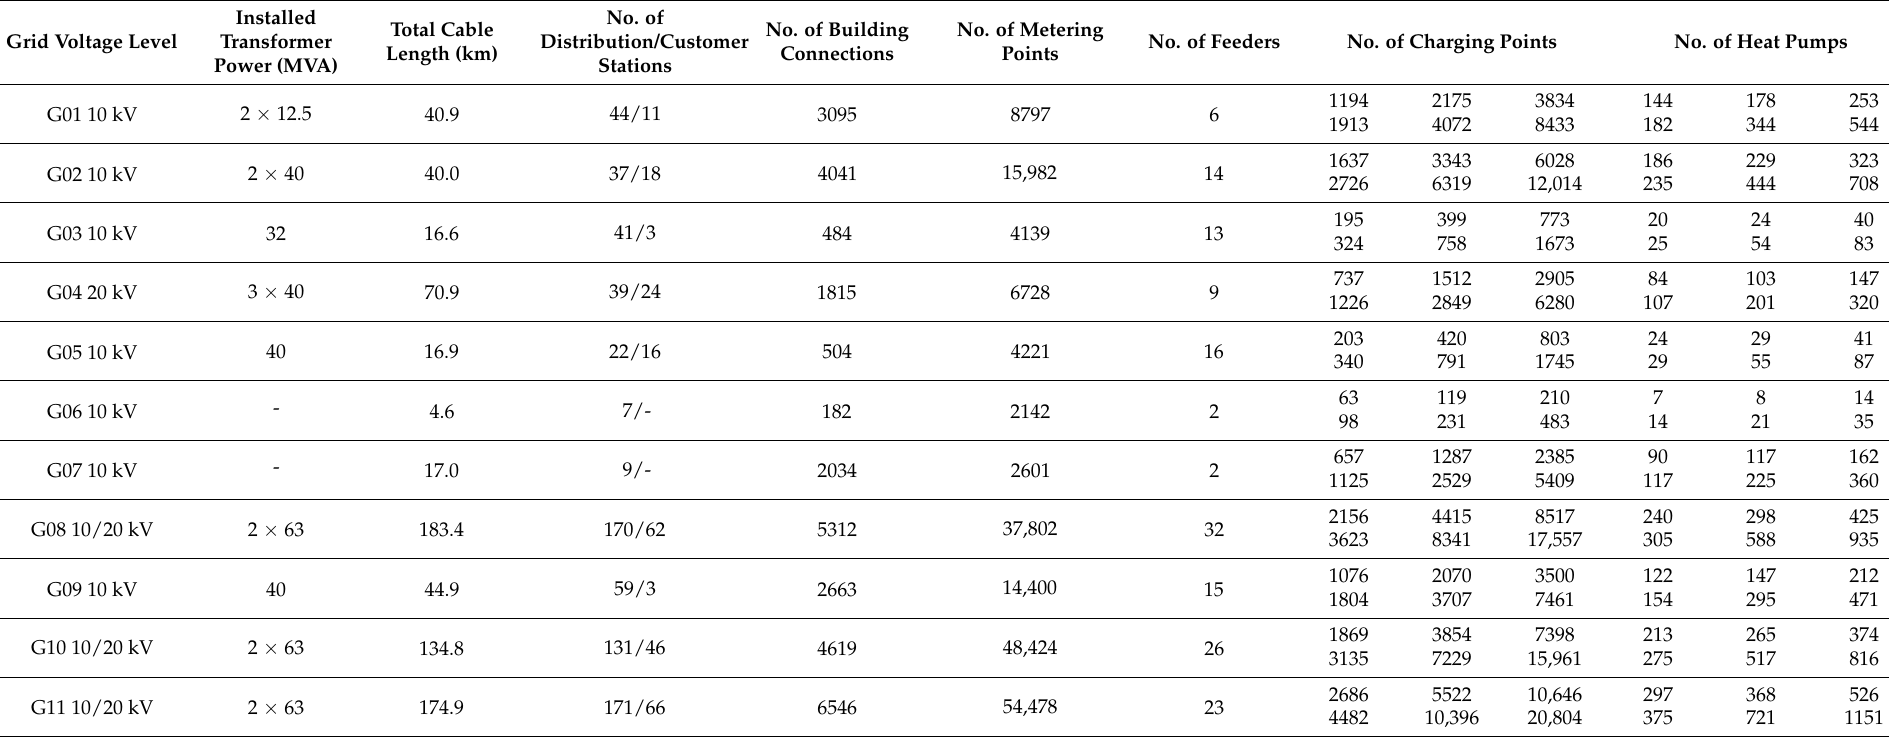
Table A1. Grid structure parameters of the investigated grids (values of the charging points and heat pumps for each grid: the first row is the conservative scenario, the second row is the progressive scenario, where the first column is the year 2030, the second column is the year 2040 and the third column is the year